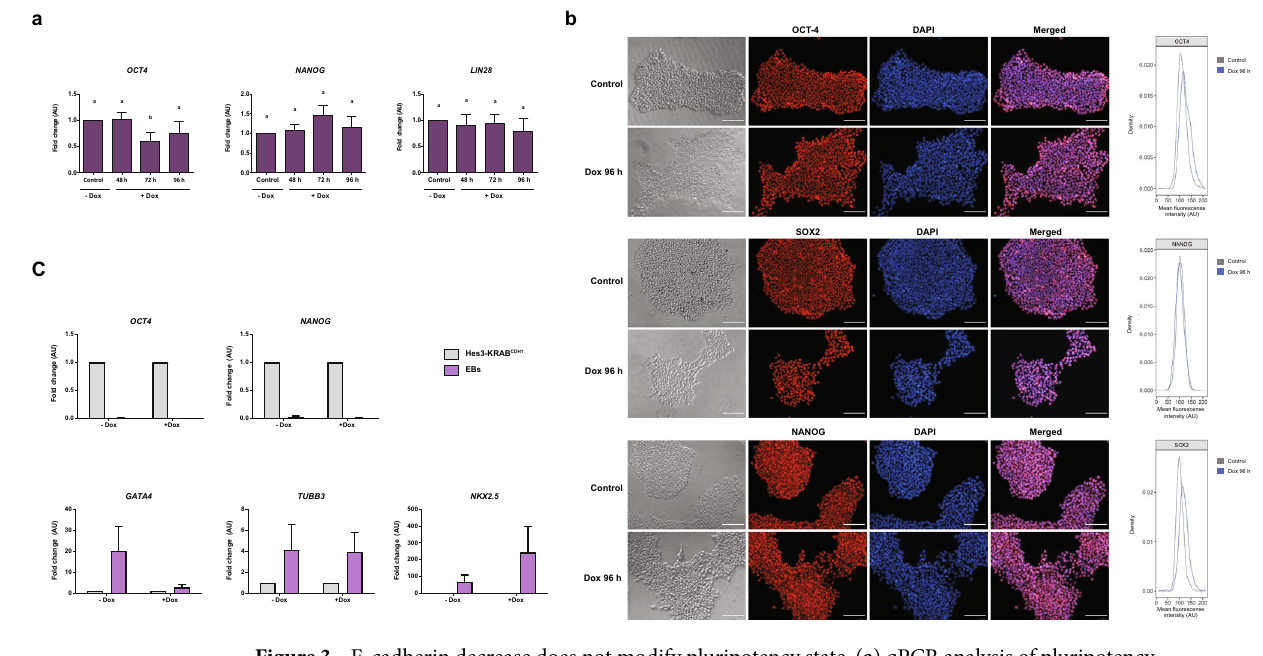
Figure 3. E-cadherin decrease does not modify pluripotency state. ( a ) qPCR analysis of pluripotency genes OCT4 , NANOG and LIN28 after Dox treatment of HES3-KRAB CDH1 cells at different times. AU is the abbreviation for arbitrary units. Results are represented as mean ± SD (n = 5). ANOVA with post hoc Tukey. Different letters indicate significant differences of groups compared to control condition (p < 0.05). ( b ) Immunofluorescence and quantification of mean fluorescence intensity of OCT-4 (upper panel), SOX2 (middle panel) and NANOG (lower panel) (red) in HES3-KRAB CDH1 cells. Nucleus were stained with DAPI (blue). Scale bar 100 µm. ( c ) Expression of NANOG and OCT-4 (pluripotency genes), GATA4 (endoderm gene), NKX2.5 (mesoderm gene) and TUBB3 (ectoderm gene) in HES3- KRAB CDH1 cells and embryoid bodies (EB) with or without Dox treatment for 96 h. AU is the abbreviation for arbitrary units. Results are represented as mean ±